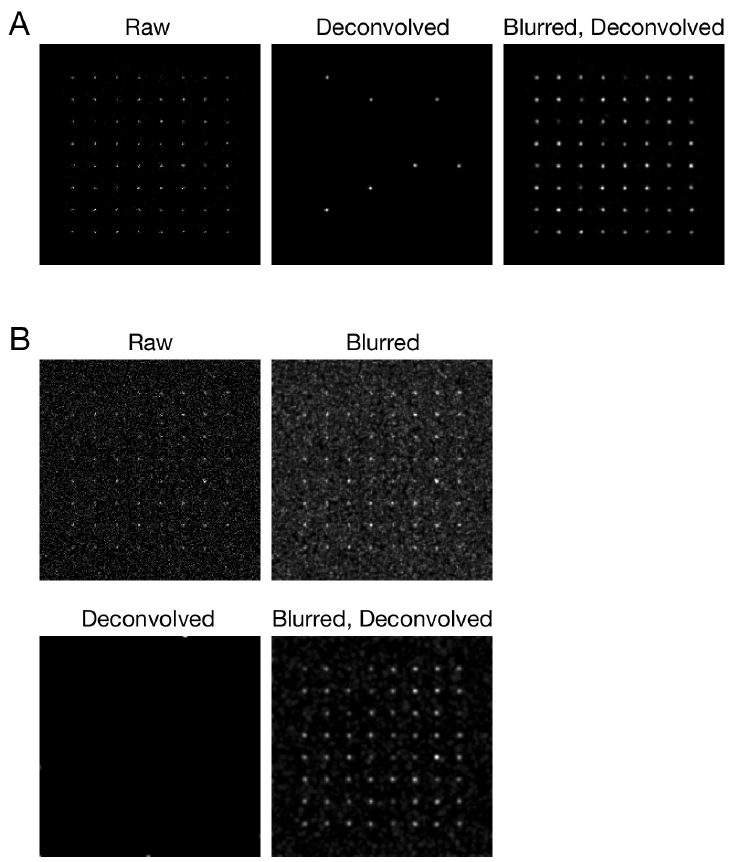
Figure 3. Improved deconvolution of simulated data with a Gaussian blur prefilter. Simulated confocal Z-stacks of fluorescent point sources were created as described in Methods, either ( A ) without background noise or ( B ) with background noise. The data were processed and average projected as in Figure